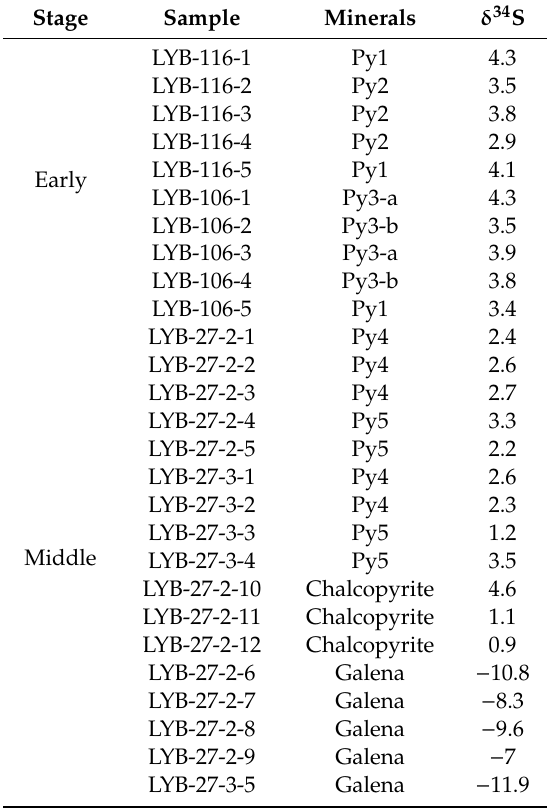
Table 3. Sulfur isotope compositions (% (cid:24) ) of sulfides analyzed in this study. Stage